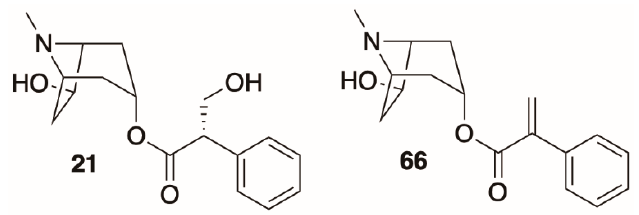
Figure 7. 3,7-Disubstituted tropanes found in Datura .